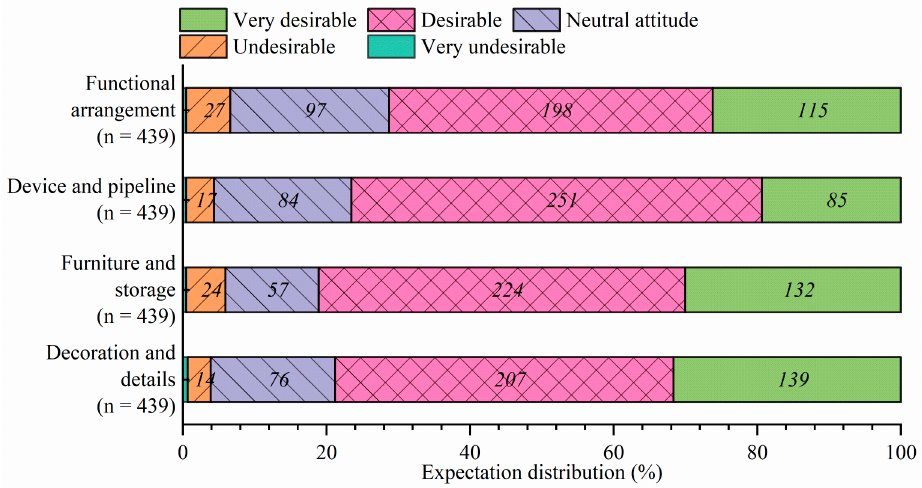
Figure 3. Expectations for flexibility in four areas of housing design.